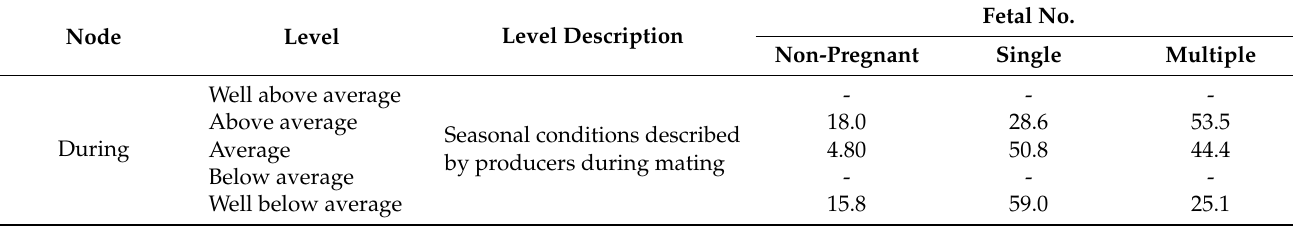
Table 7. The estimated probabilities for shedding fetal number (no., displayed as percentages) for each node (variable) when the different levels within each node are assumed in the Bayesian Network (BN) model, where BCS = body condition score. Level descriptions detail the data and naming conventions within each level of the model. A dash (-) indicates data were not applicable for the respective level. The BN model assessed the interrelationships between pregnancy outcome and fetal number of shedding ewes. Data displayed to three significant figures (rather than decimal places), as such the row total percentage value may be slightly different from 100% due to rounding errors. Letter prefixes are defined as: LT = less than, E = a range of values around the displayed value and GT = greater than. Region abbreviations are defined as: NSW = New South Wales, VIC = Victoria, QLD = Queensland and SA = South